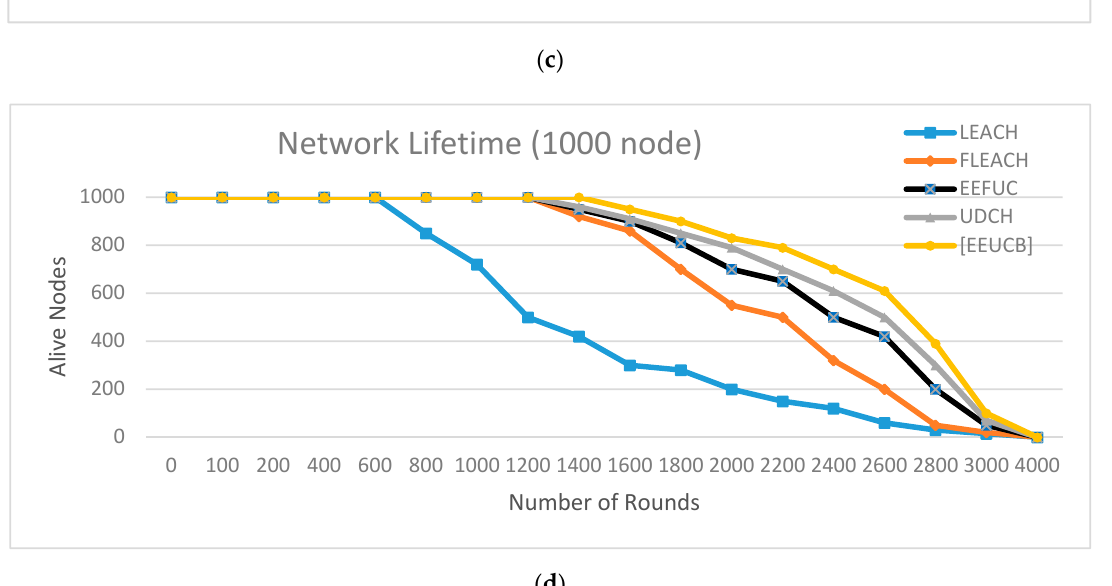
Figure 11. The network lifetime with ( a ) 100 nodes, ( b ) 300 nodes, ( c ) 400 nodes, ( d ) 1000 nodes. In addition, we tested the statistical significance of the number of alive nodes (NOA) by using two-tailed T.TEST to draw a statistical inference as defined by [39,40]. A large sample consisting of pair of (NOA) in the proposed EEUCB protocol with other protocols